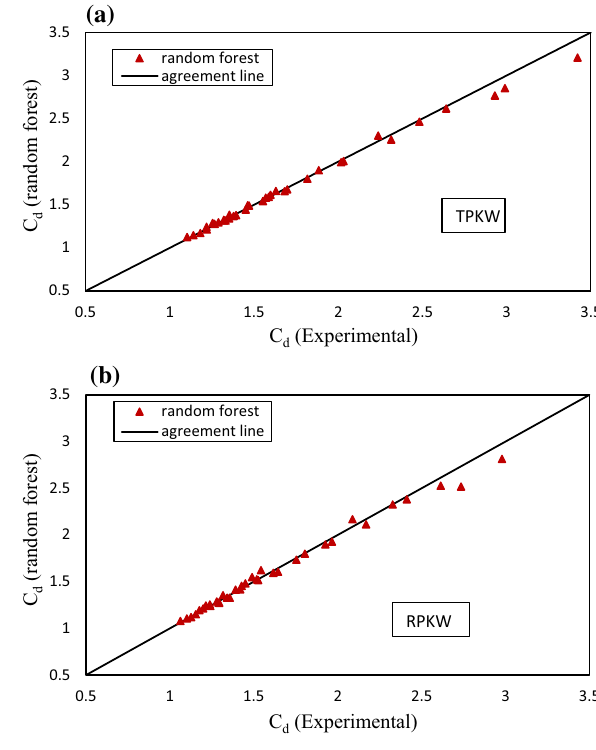
Fig. 10 Experimental versus predicted values of Cd using random forest method for a trapezoidal, and b rectangular PK weirs